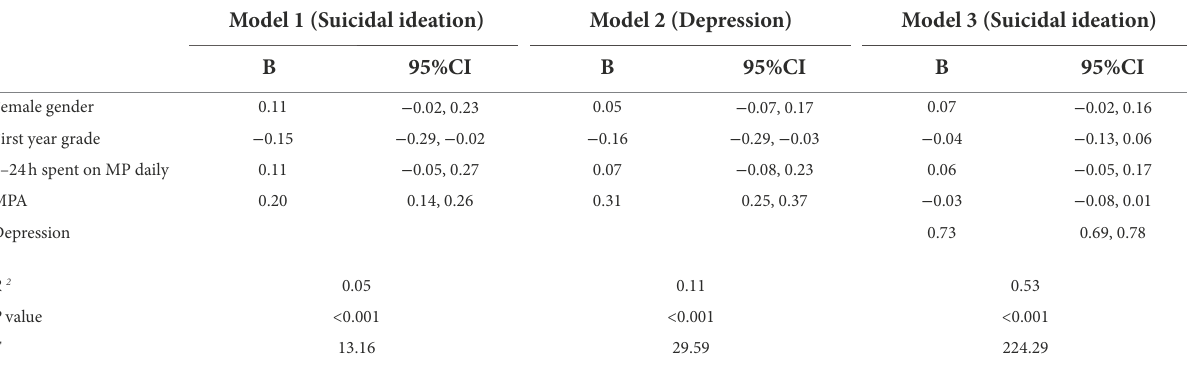
TABLE 3 Mediation effect analyses for the association between mobile phone addiction and suicidal ideation via